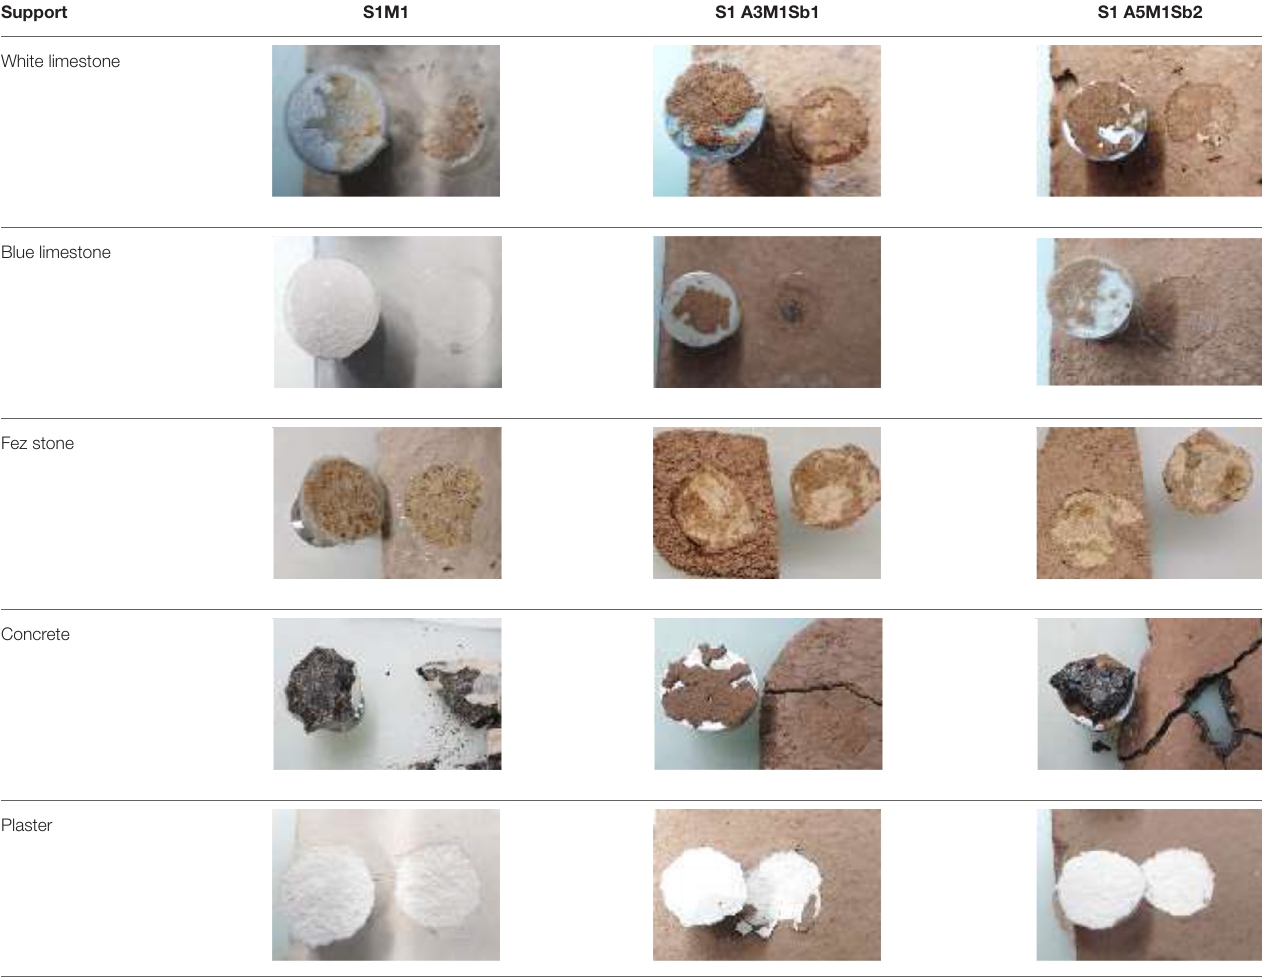
TABLE 5 | Picture of the adhesive and cohesive failures of the three coatings applied on the five substrates, stocked at 20 ◦ C, 50% HR, during the pull-off tests.